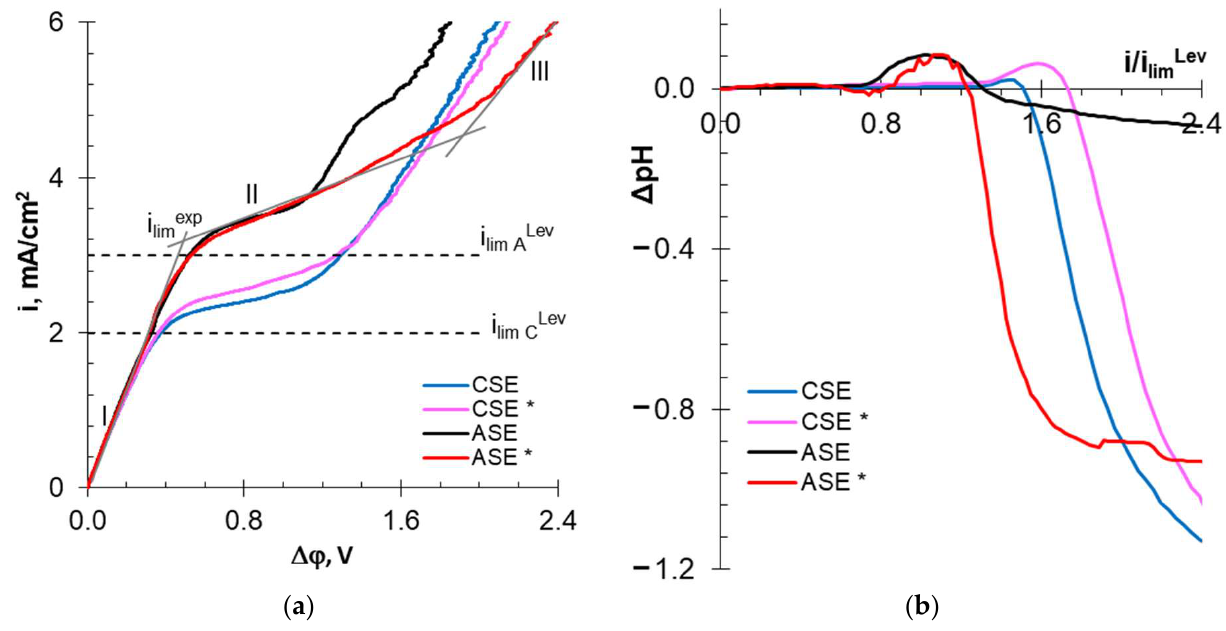
Figure 8. Current–voltage curves ( a ) of aromatic membranes before (CSE and ASE) and after (CSE * and ASE *) electrodialysis processing of the model solution, as well as the dependence of the solution pH difference at the DC output and input upon the current density normalized to the calculated limiting current ( b ). The dependences of ΔpH vs . i/i limLev were obtained in parallel with the CVC measurements. The studies were carried out in 0.02 M NaCl solution.